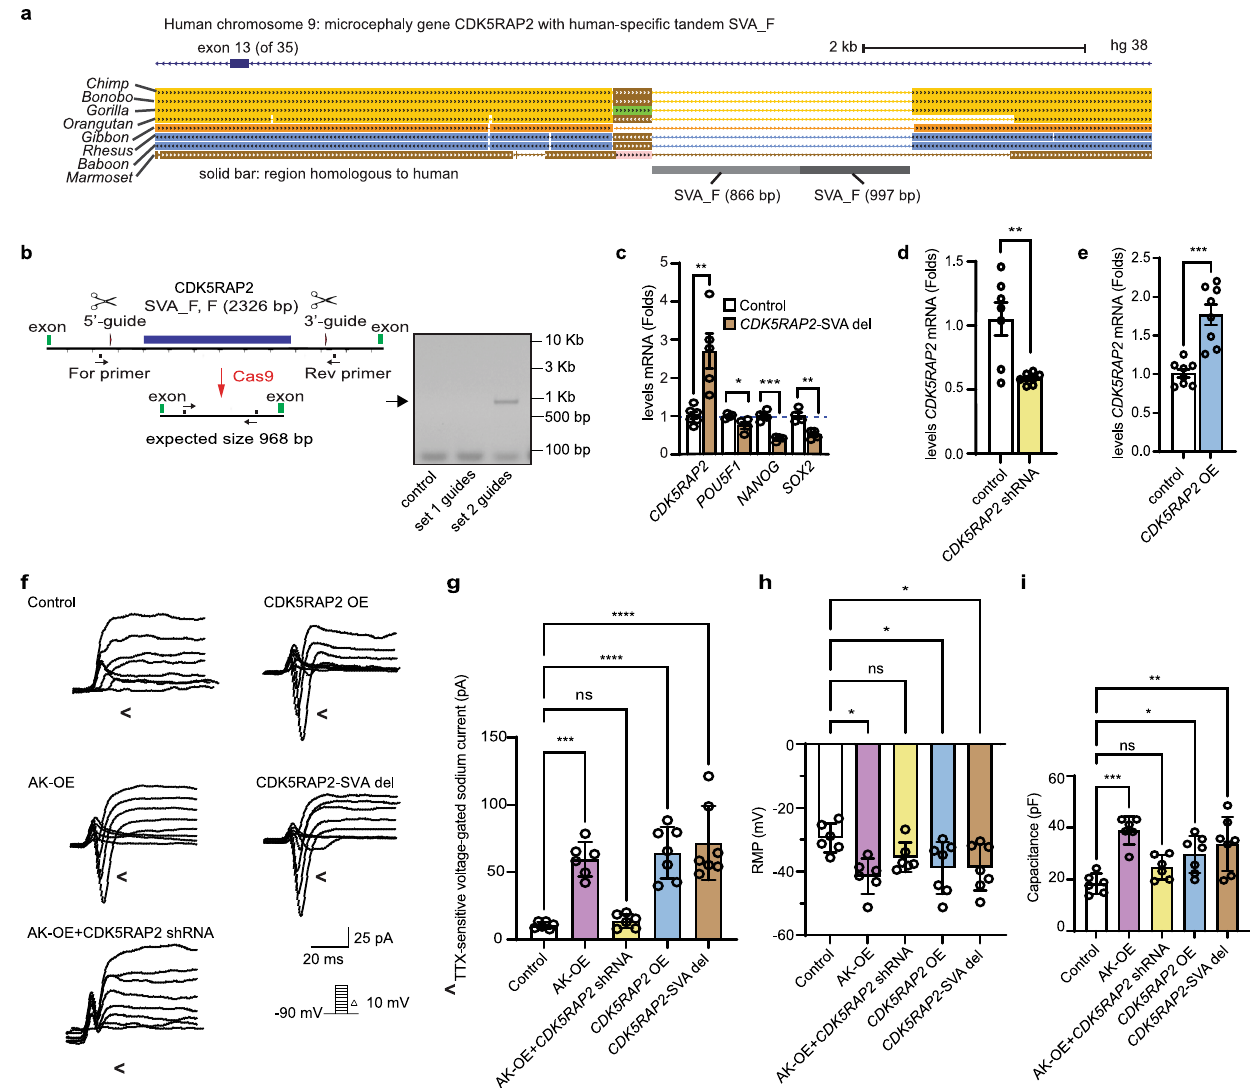
Fig. 3 A human-speci fi c tandem SVA-F in CDK5RAP2 represses its expression to delay, whereas SVA-lncRNA AK057321 enhances CDK5RAP2 expression to promote neuronal maturation. a Tandem human-speci fi c SVA_F in microcephaly gene CDK5RAP2 gene intron (UCSC genome browser, GRCh38/gh38). b Schematic for Crispr/Cas9 tandem SVA_F, F deletion strategy with DNA agarose gel image showing expected SVA-deletion PCR product size of 947 bp present only in set 2 guides which were used for all subsequent experiments. c , NTera-2 cells transfected with set 2 guides were sorted and analyzed for gene expression by RT-qPCR. n = 4 biological replicates. d RT-qPCR of NTera-2 cells transfected with CDK5RAP2 shRNA show decreased CDK5RAP2 mRNA expression compared to control cells. n = 7 biological replicates. e RT-qPCR from NTera-2 cells transfected with CDK5RAP2 cDNA and induced with doxycycline have increased CDK5RAP2 gene expression. n = 8 biological replicates. c – e Unpaired two-tailed Student ’ s t test for each with GAPDH as the internal reference gene. f TTX-sensitive currents were recorded in voltage clamp mode. Representative sodium current traces in response to step depolarization were shown. g TTX-sensitive inward currents were larger in AK057321 OE ( n = 7), CDK5RAP2 -OE ( n = 7) and CDK5RAP2 - SVA del ( n = 6) del groups than those in the control group. AK057321 OE + CDK5RAP2 shRNA has no signi fi cant difference compare to control. One-way ANOVA ( F 5,36 = 29.44, p < 0.0001) with Bonferroni post hoc tests. h Resting membrane potential (RMP) is hyperpolarized in AK057321 OE ( n = 7), CDK5RAP2 -OE ( n = 7) and CDK5RAP2 -SVA del ( n = 6) del groups than those in the control group. AK057321 OE + CDK5RAP2 shRNA has no signi fi cant difference compared to control. One-way ANOVA ( F 5,36 = 29.44, p < 0.0001) with Bonferroni post hoc tests. i Capacitance was larger in AK057321